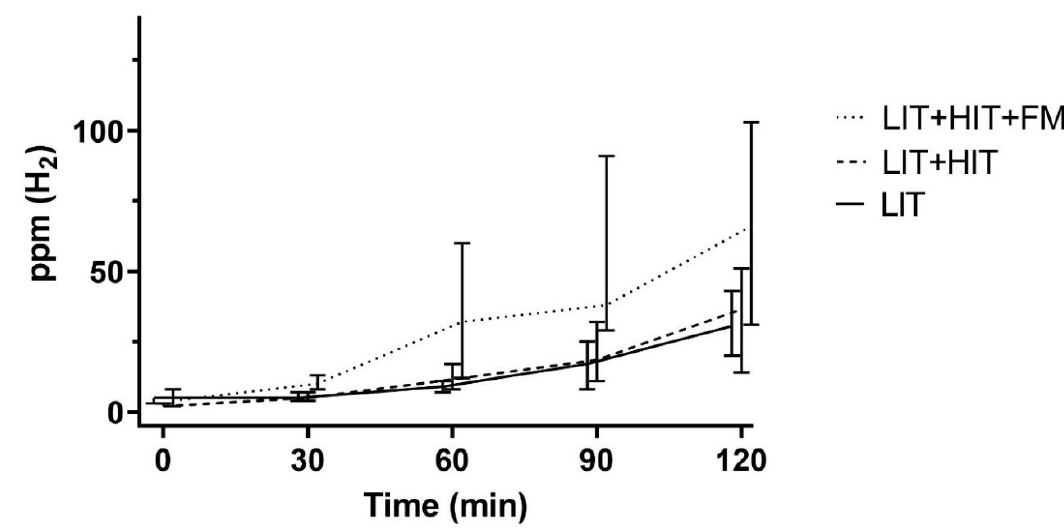
Figure 1. Medians and 95% confidence intervals of H 2 ppm during lactose H 2 breath tests in 279 patients with LIT. Included are 128 LIT-only patients, 106-LIT patients with additional HIT, and 45-LIT patients with HIT and FM. Fructose malabsorption, FM; histamine intolerance, HIT; H 2 , hydrogen; lactose intolerance, LIT; ppm, parts per million.